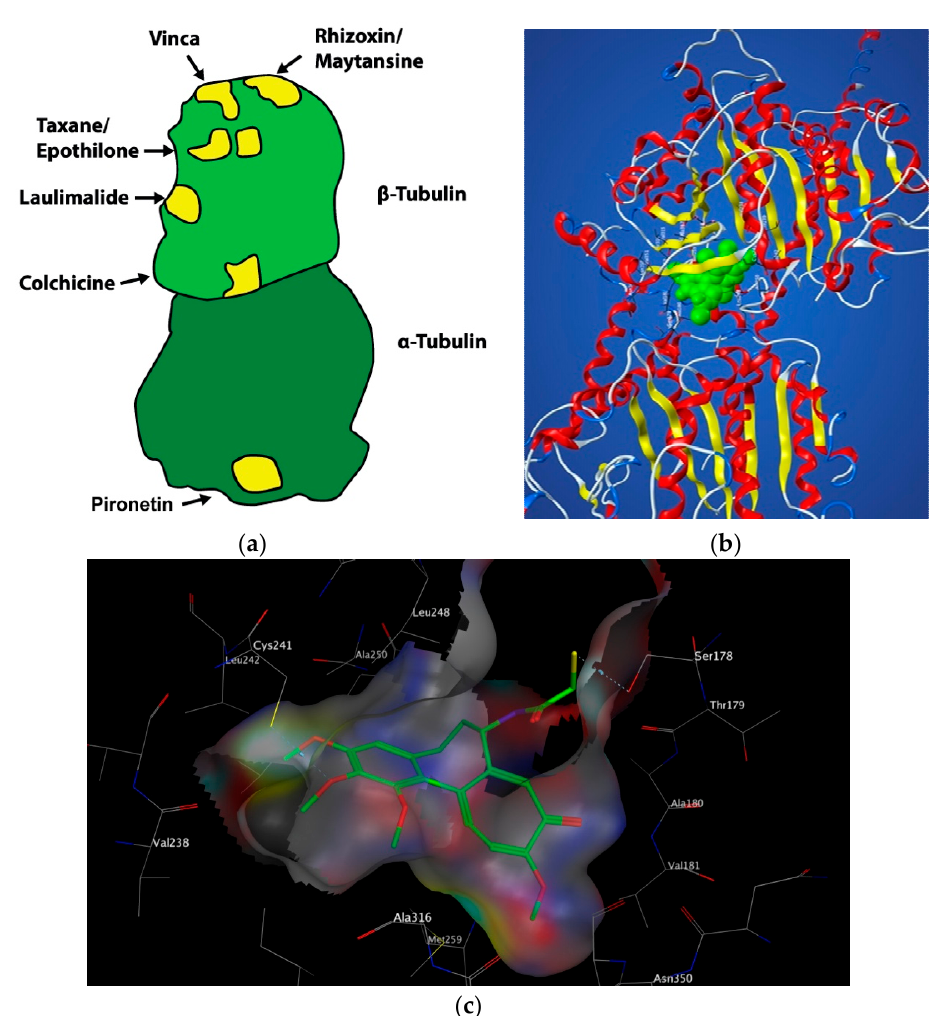
Figure 2. ( a ): Schematic representation of the different drug-binding sites on tubulin. ( b ): Space-filling model of colchicine (green) in the colchicine-binding site (CBS). ( c ): Model of N-deacetyl-N-(2-mercaptoacetyl) colchicine (DAMA)-colchicine bound at the interface of αβ -tubulin. Key binding interactions are with Thr179 and Val181 of α -tubulin and Cys241 and Asn258 of β -tubulin. Colour key: green = carbon; red = oxygen; blue = nitrogen; yellow = sulphur.